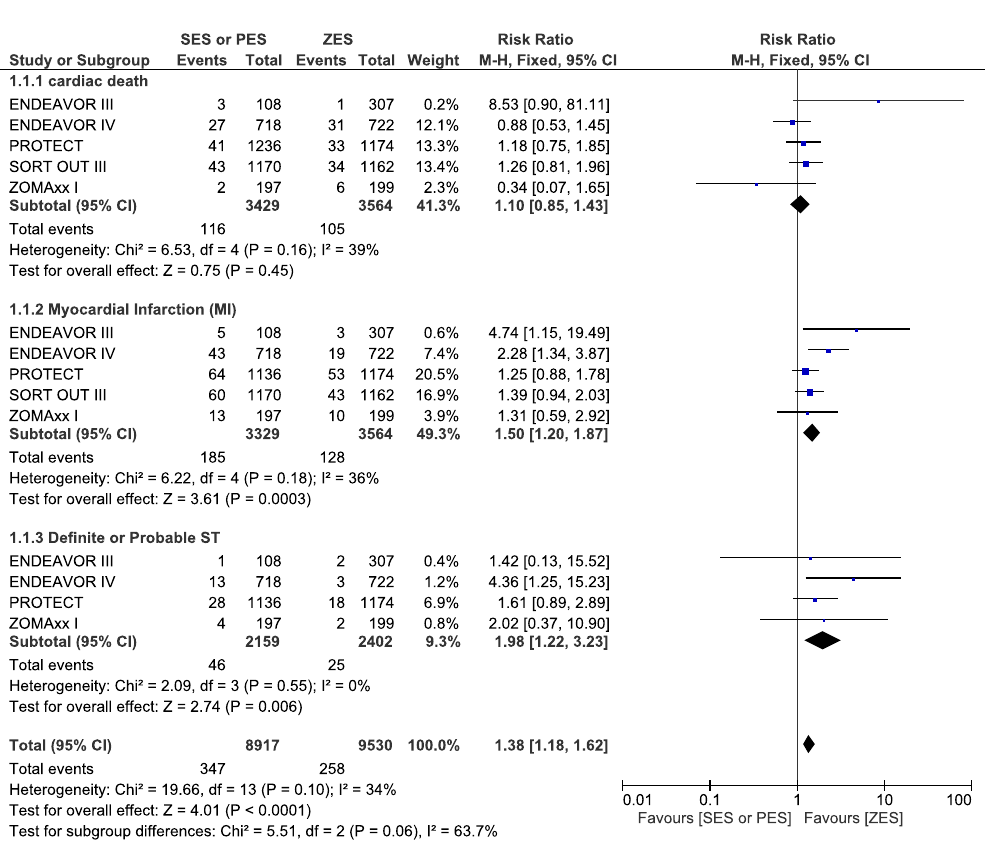
Figure 11. Adverse clinical outcomes which were associated with ZES versus SES or PES at 4–5 years follow-up (part 1).